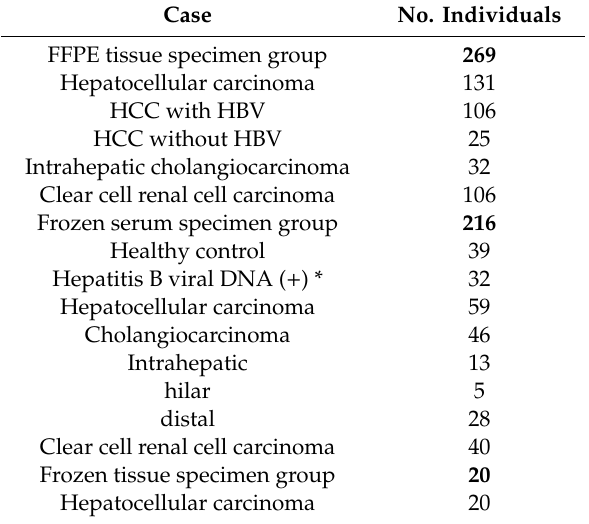
Table 1. Summary of the materials from the 505 study individuals. Case No.